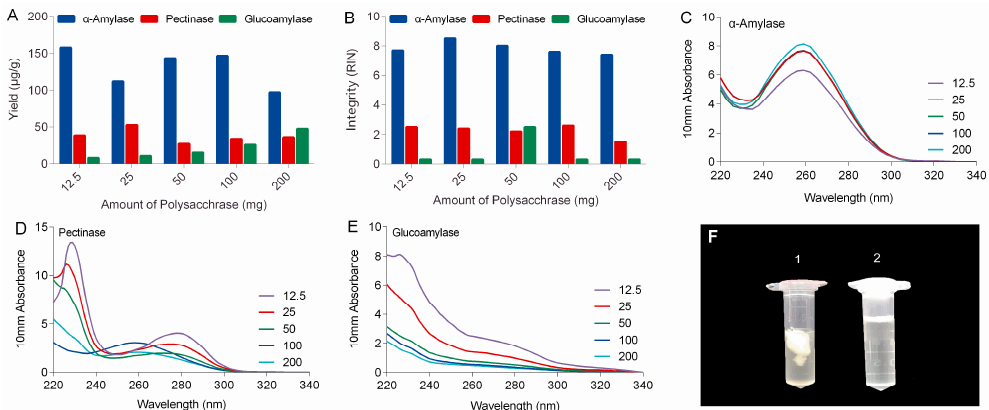
Figure 1. Comparison of the yield ( A ), integrity ( B ), and purity (Nanodrop spectrophotometric measurements in C , D , and E ) of total RNA isolated from ginseng roots using PARI method with different amount of α -amylase, pectinase and glucoamylase. ( F ) Comparison of precipitation before (no. 1) and after (no. 2) α -amylase digestion.